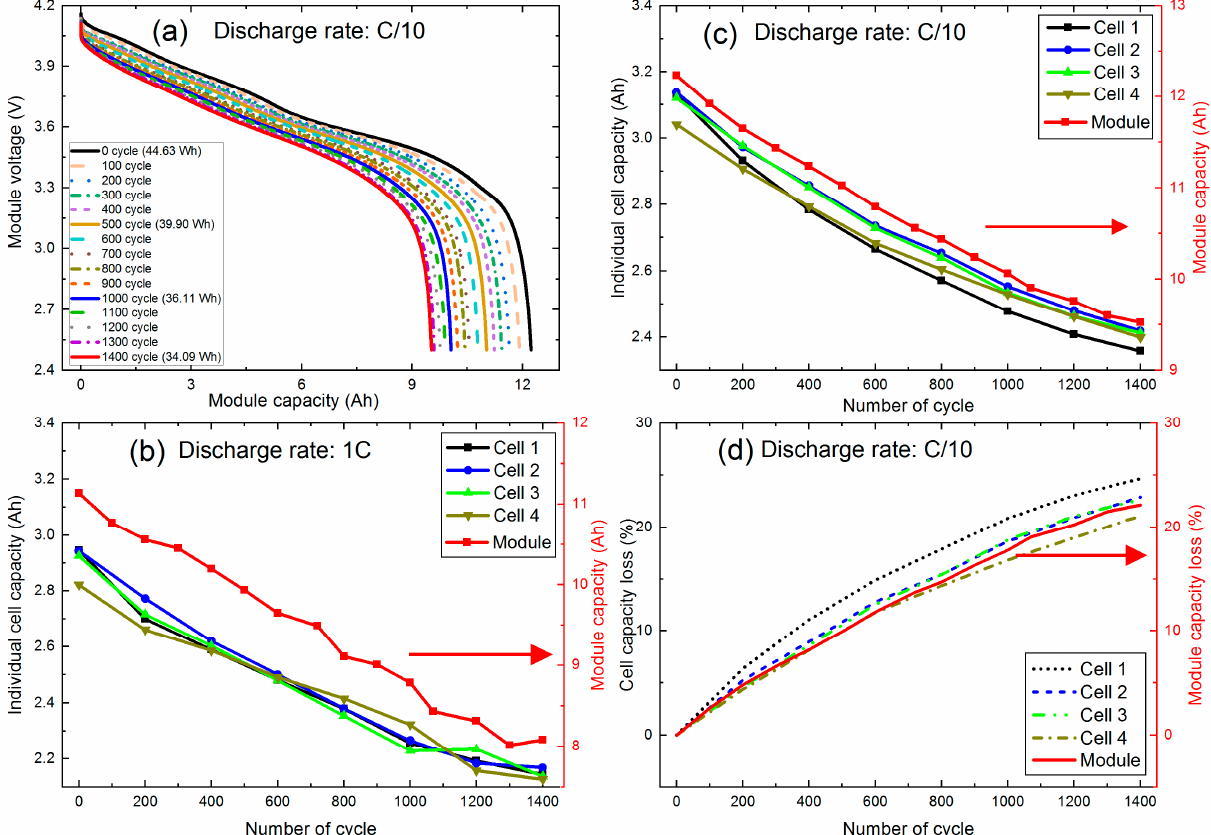
Figure 6. Capacity degradation of the module and individual cells, ( a ) voltage vs. module capacity as a function of ageing cycles, ( b ) 1C capacity of the module and individual cells, ( c ) C/10 discharge capacity of the module and individual cells, and ( d ) normalized C/10 capacity degradation. The module level capacity tests were done at 30 °C in cell C1 and 20 °C in the other three cells. Individual capacity tests were done at 25 °C in all four cells.